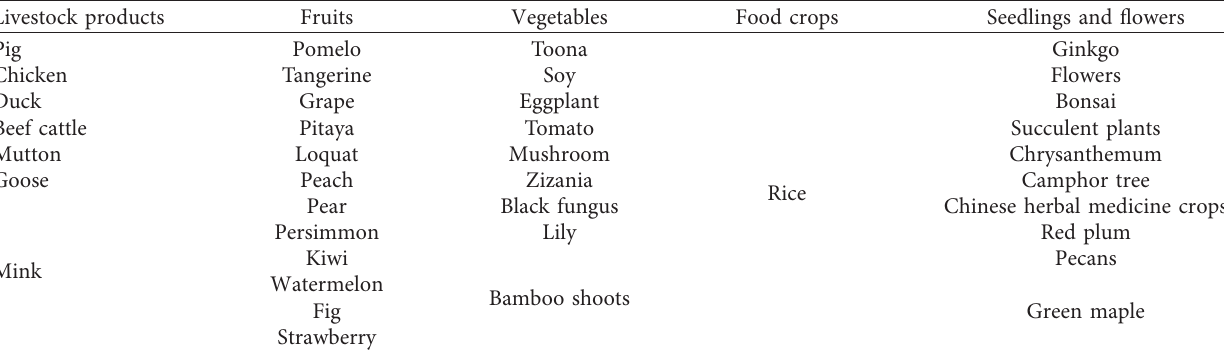
Table 3: Classification of sample